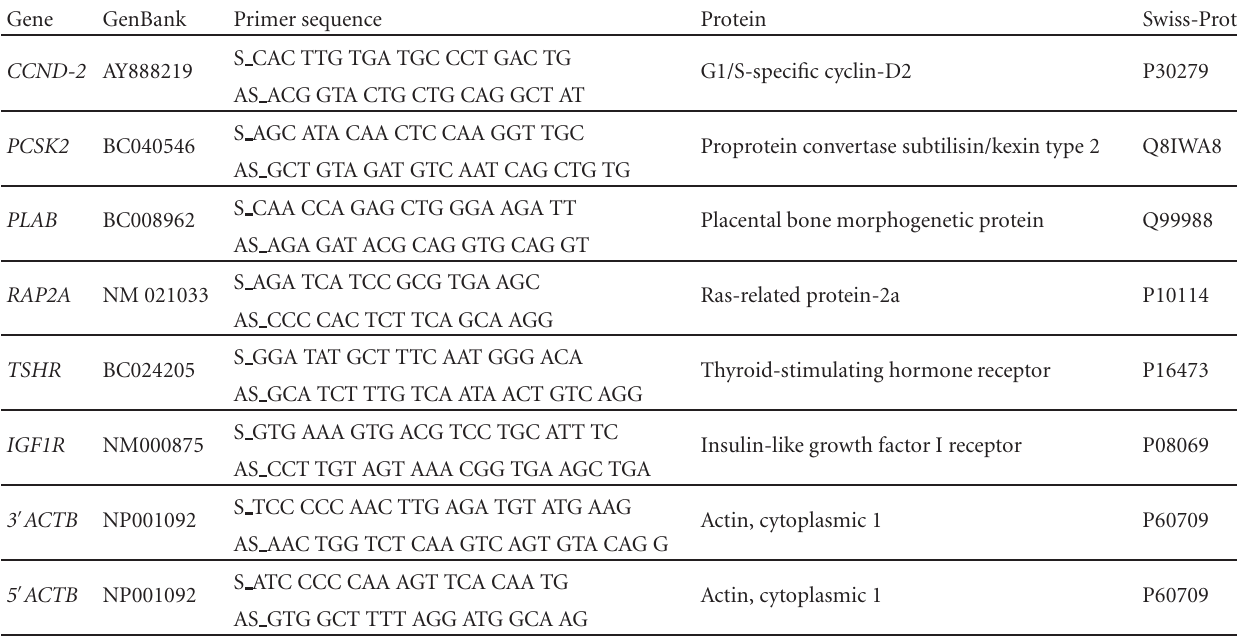
Table 2: A list of tested genes and encoded by them proteins, including the gene and protein accession numbers and corresponding intron- spanning primers used for